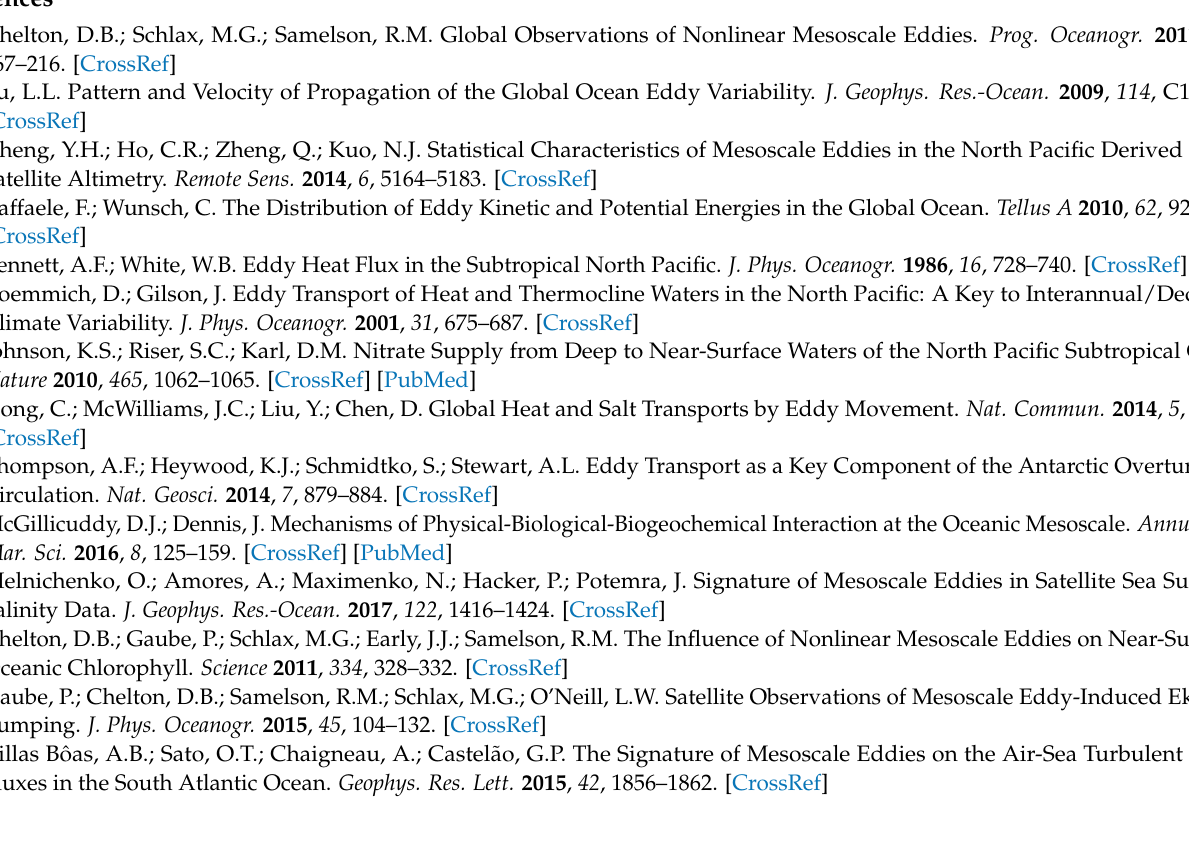
Figure S3: Time series statistics and ratio scatter diagrams of three parameters (eddy radius,